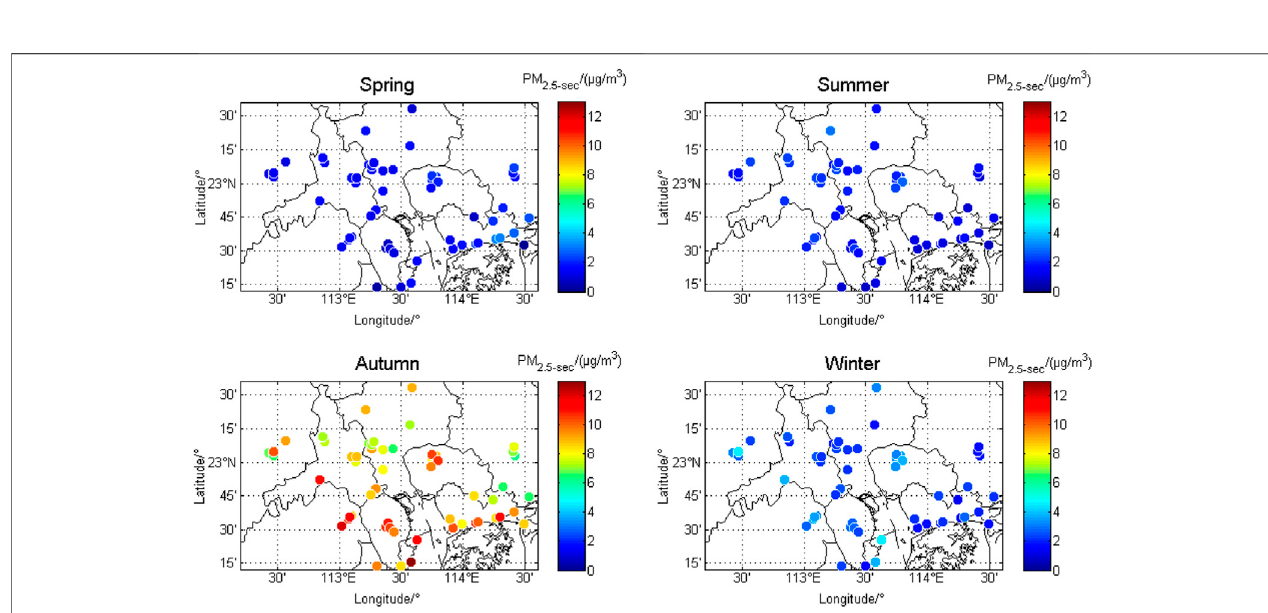
FIGURE 8 | Seasonal variations of PM 2.5-sec in the PRD.